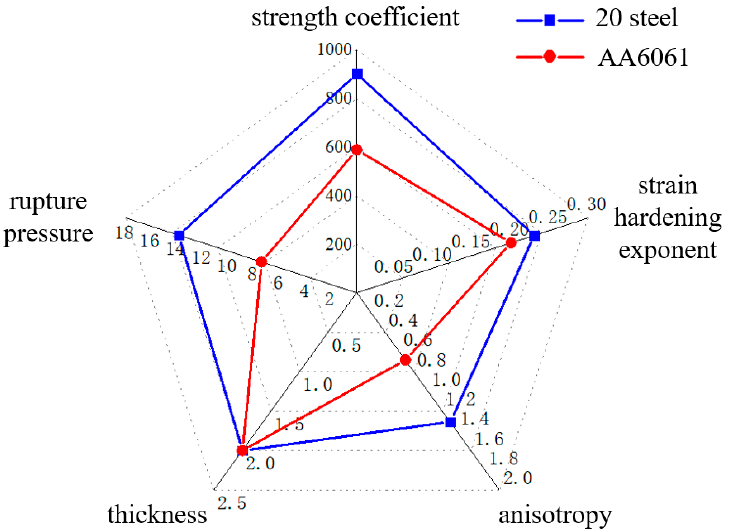
Figure 12. Comparison of critical rupture pressure between 20 steel and AA6061 using TUBG.